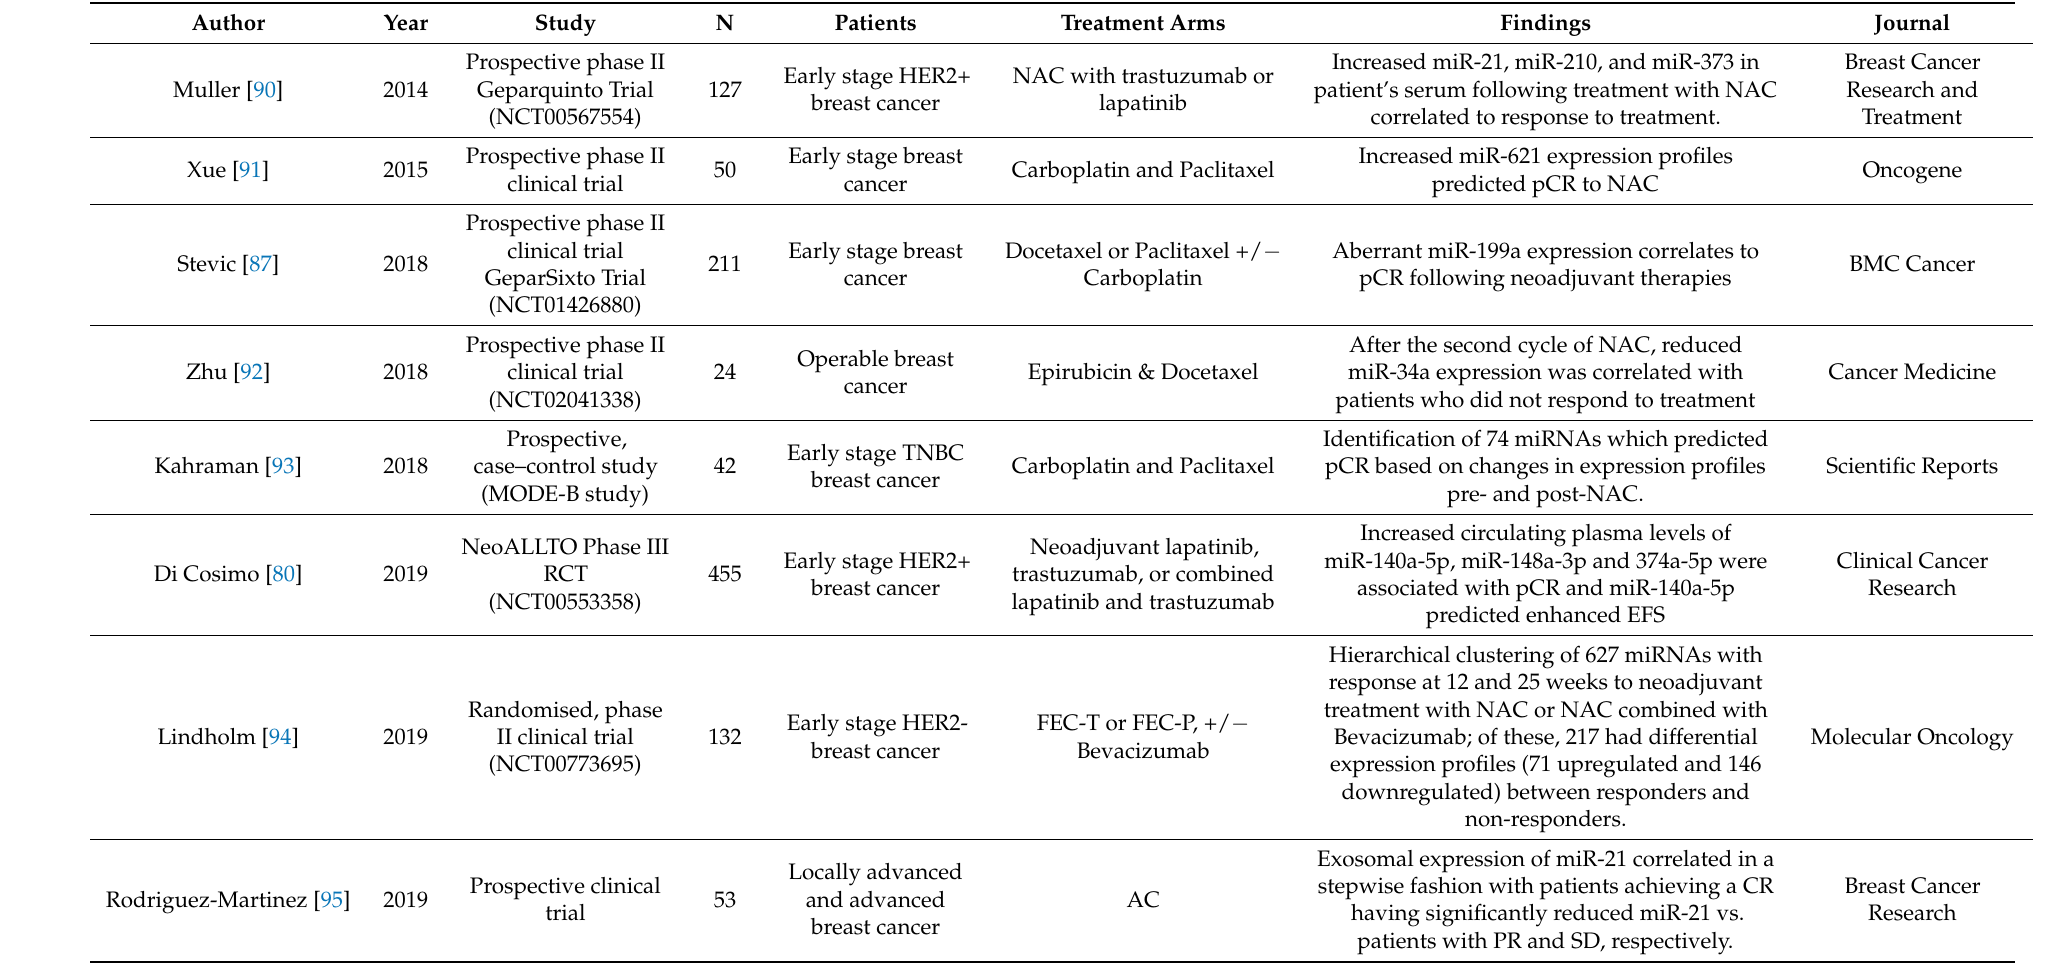
Table 3. Table illustrating prospective trials evaluating the role of miRNAs in predicting response to neoadjuvant